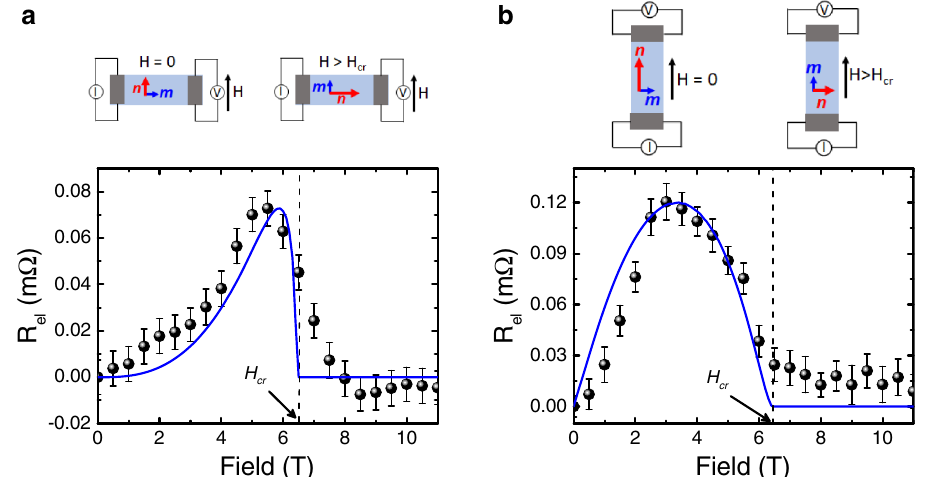
fi eld initially and fi eld, no zero- fi eld spin transport is observed. R el increases with reaches a maximum at μ 0 H = 3T followed by a decrease and the signal diminishes above critical fi eld. The error bars are the standard error of the mean. In both curves, the signalisplotted after subtracting the offsetatzero fi eld. The solid blue lines based on the theoretical model are described in the text. In both of the geometries, the centre-to-centre distance between the wires is about